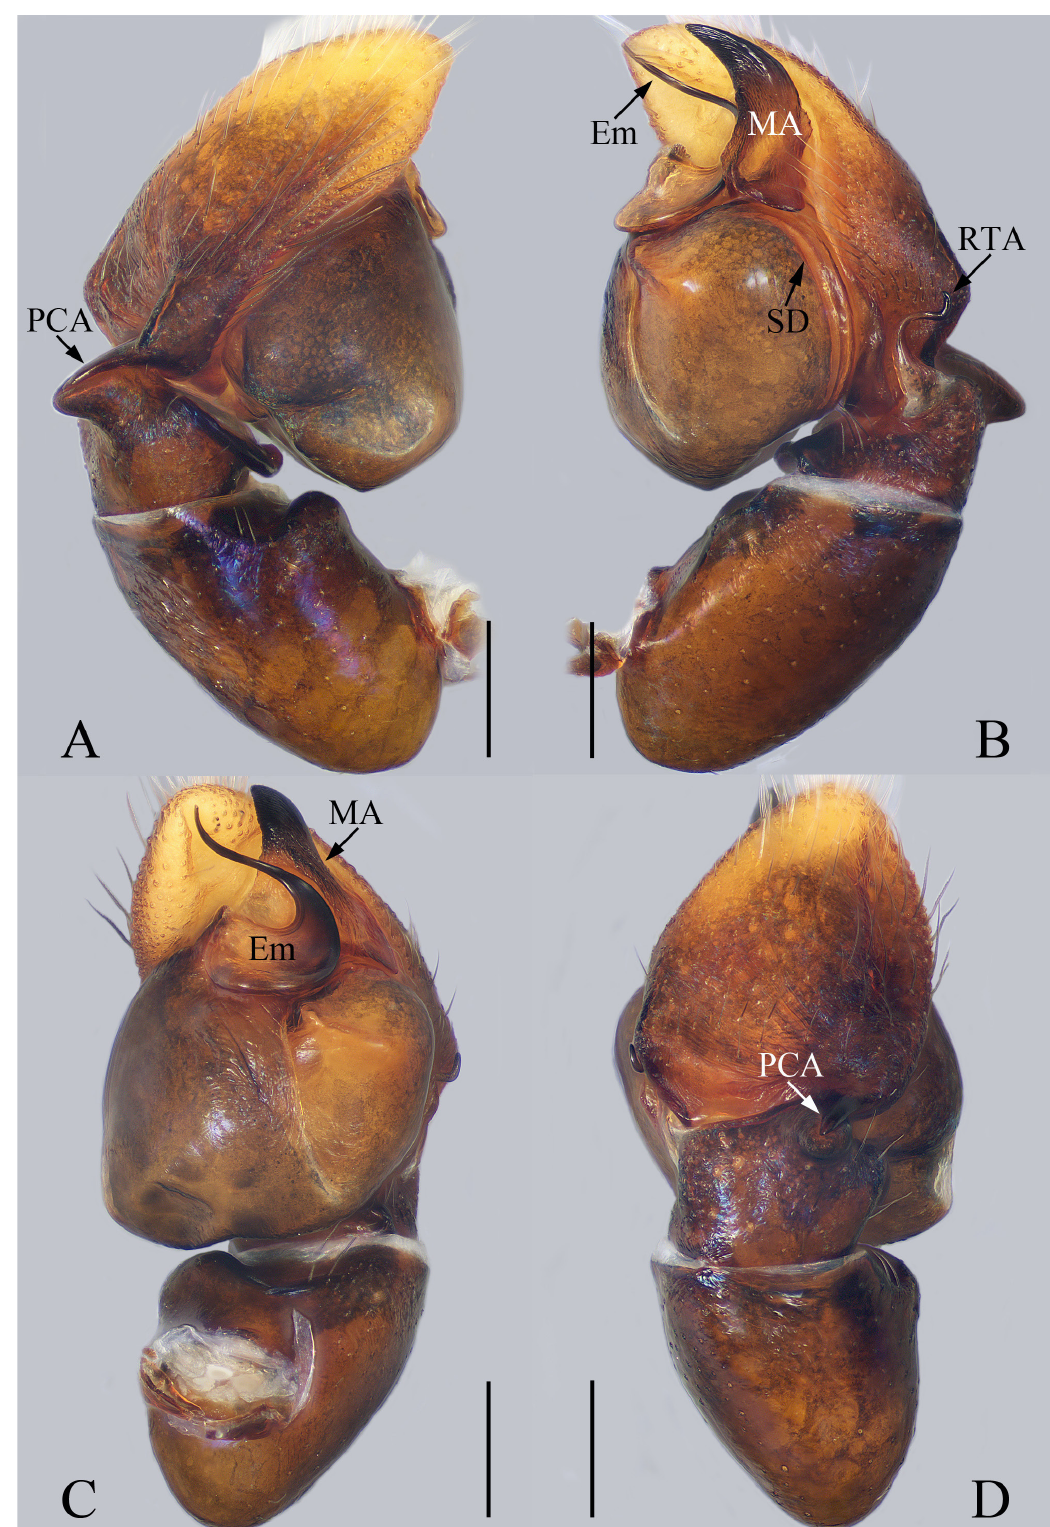
Fig. 1. Male palp of Synagelides bohdanowiczi sp. nov., holotype, ♂ (TRU-Salticid-0010). A . Prolateral view. B . Retrolateral view. C . Ventral view. D . Dorsal view. Abbreviations: see Material and methods. Scale bars = 0.1